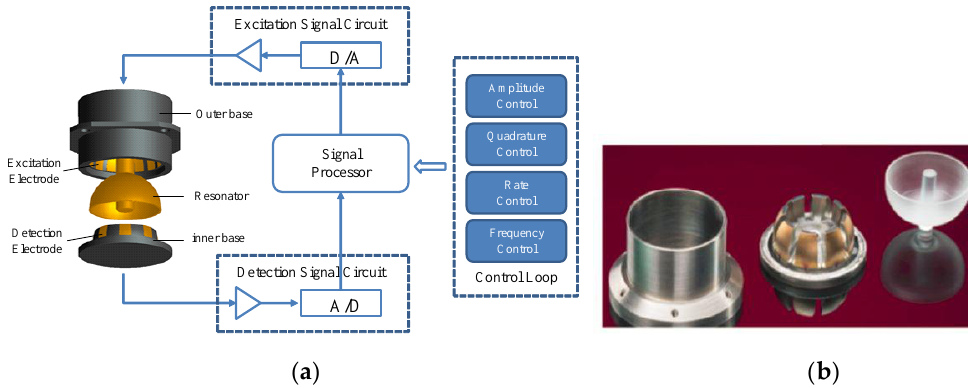
Figure 1. The basic structure of the HRG. ( a ) Simple structure diagram of the HRG; ( b ) The three main components (the resonator, inner base, and outer base).